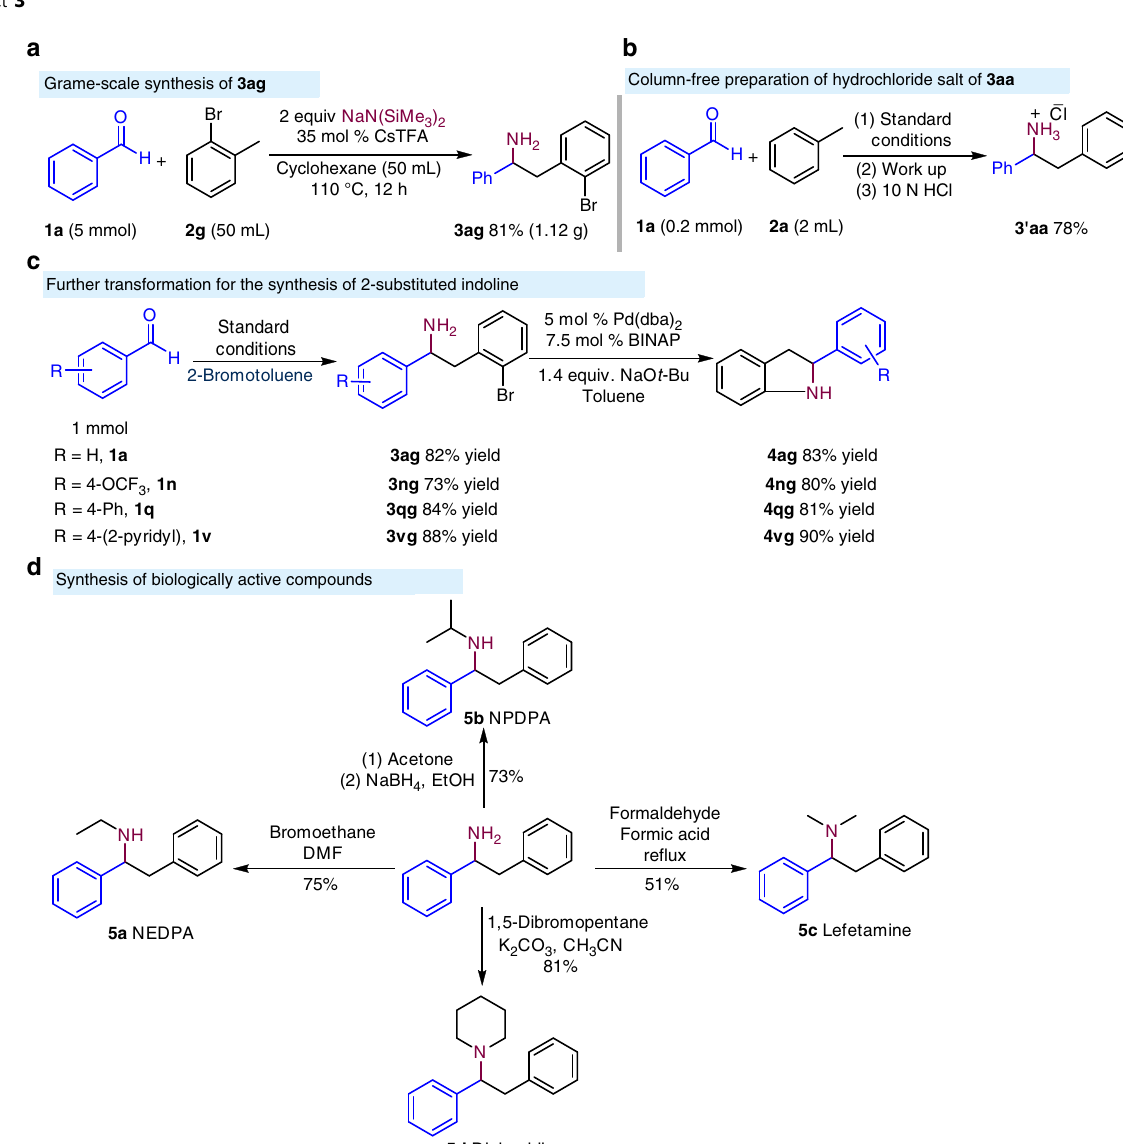
Fig. 4 Gram scale and further transformations. a Scale up of aminobenzylation. b Column-free synthesis of the hydrochloride salt of the amine product.